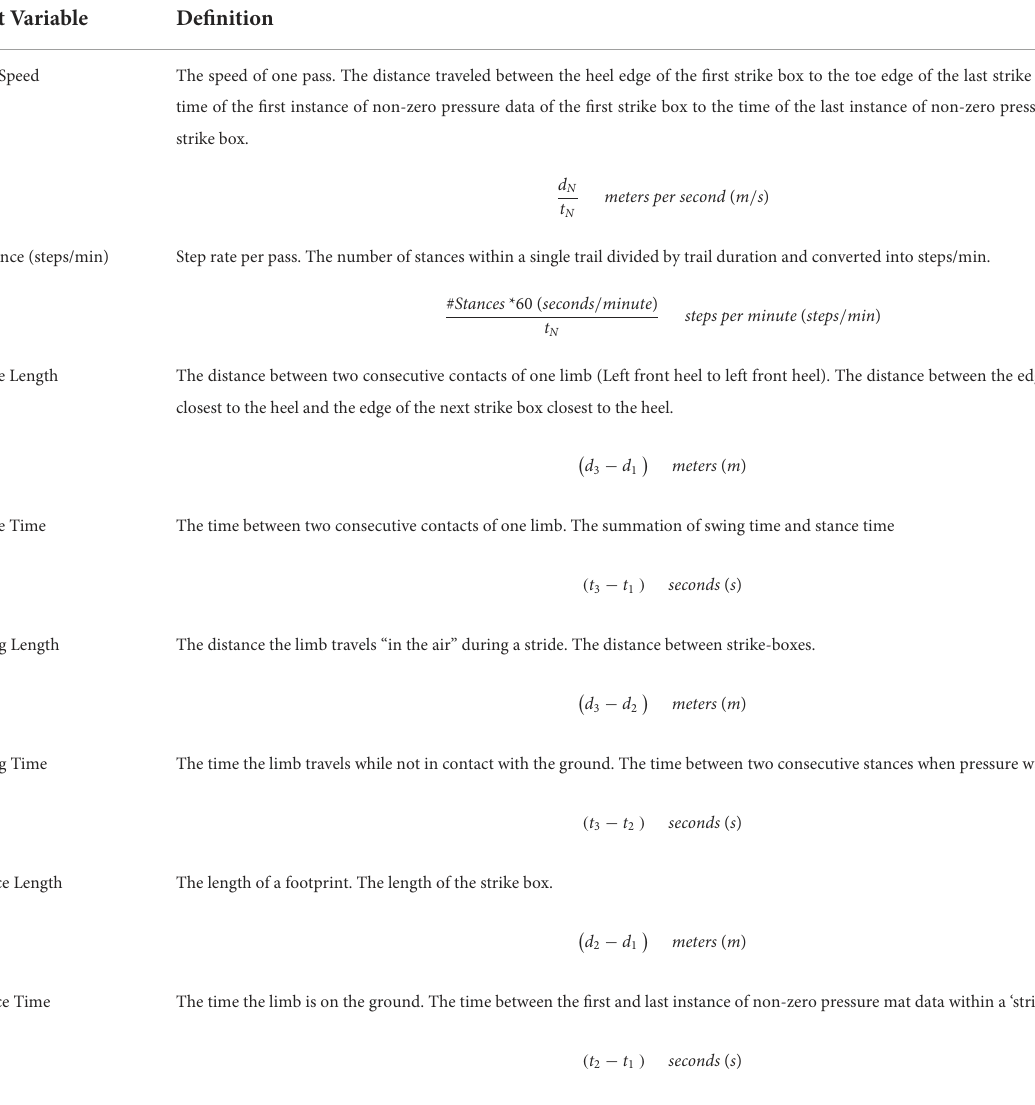
TABLE 2 Definitions of spatial and temporal gait